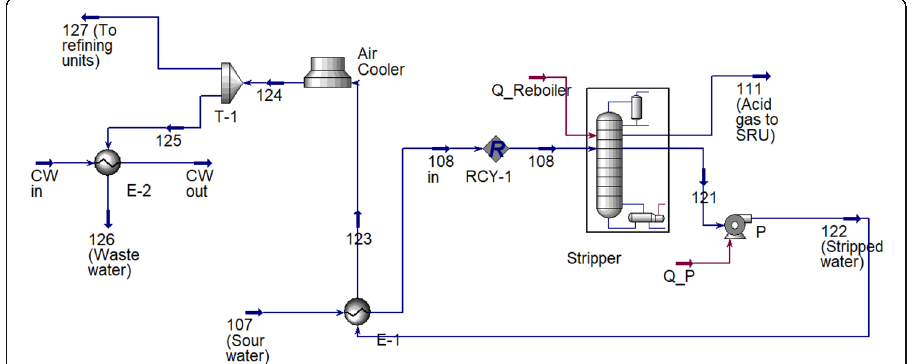
Fig. 1 Sour water stripper1